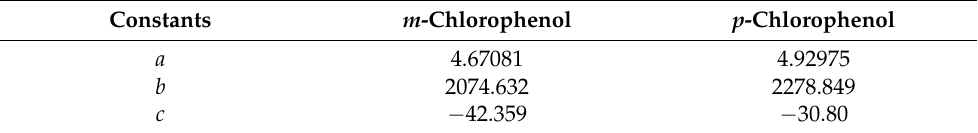
Table 2. The constants of the Antoine equation, log for m -chlorophenol and p -chlorophenol